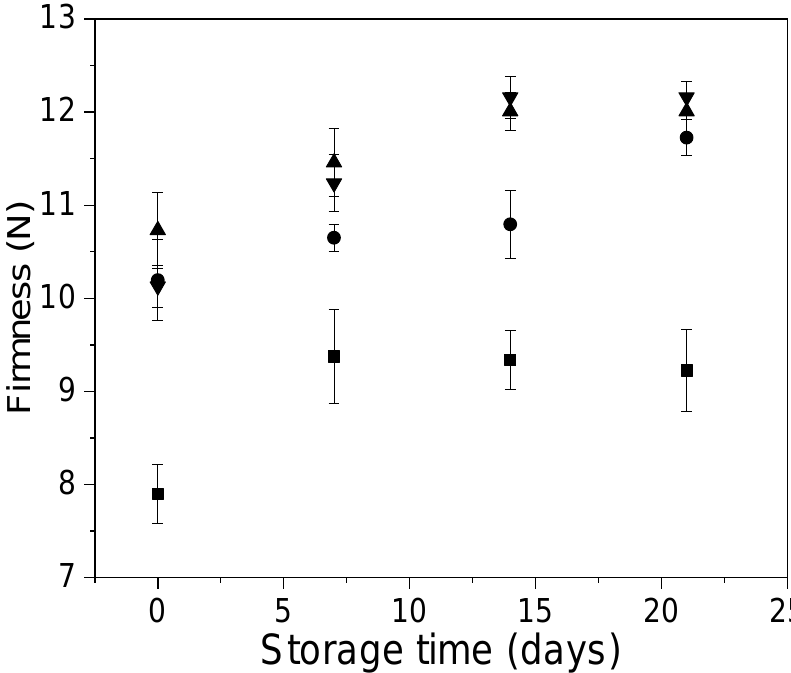
Figure 7. Changes in Andean blueberry firmness during storage. Control ( ■ ), alginate (●), alginate/CNFs 0.1% ( ▲ ), alginate/CNFs 0.3% ( ▼ ).